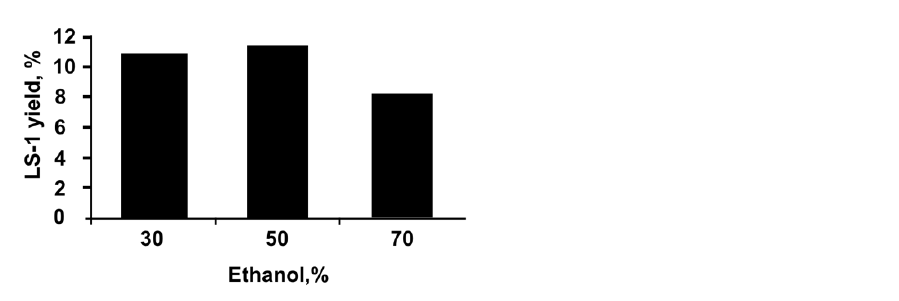
Figure 2. Elaborating optimal technology for LS-1: choosing correct concentration of extragent.